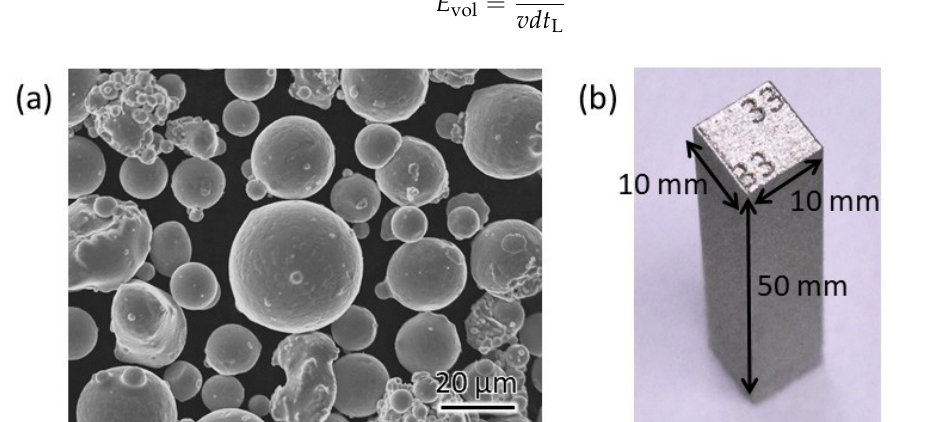
Figure 1. ( a ) A scanning electron microscopy image of Hastelloy-X powder and ( b ) a picture of a sample piece.